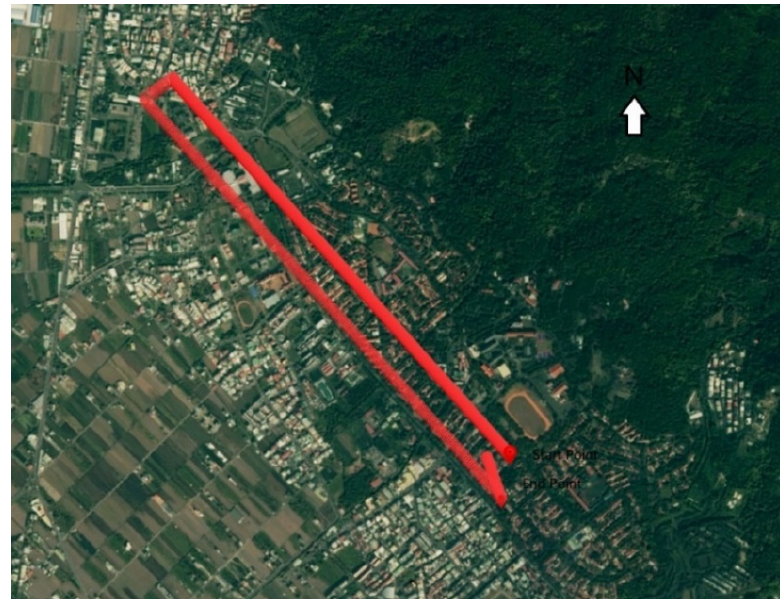
Figure 2. Unmanned aerial vehicle (UAV) flight trajectory. Table 2. The defined scenarios.